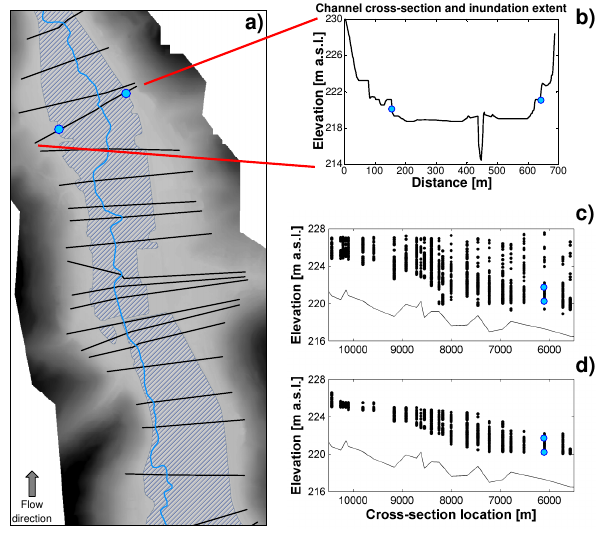
Fig. 3. Diagram showing an example of: (a) flood extent de- rived from a satellite image superimposed on the DEM and the river cross-section location, (b) illustration of water level extraction method from inundation extent and cross-section and c) the remote sensing derived water levels along a portion of stream (c) before and (d) after the hydraulic coherence